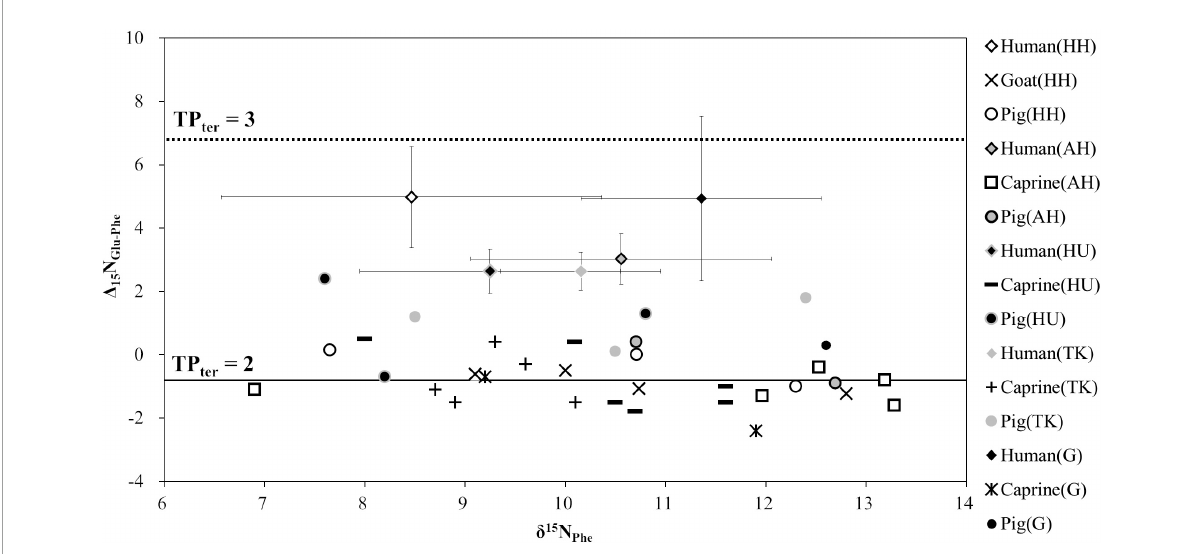
FIGURE4 Comparisons of the δ 15 N Phe and (cid:49) 15 N Glu − Phe of the human, Caprine, and Sus scrofa remains at Hasankeyf Höyük (HK), Asıklı Höyük (AH), Hakemi Use (HU), Tell el-Kerkh (TK), and Gurgy (G). Due to the large number of individuals for humans from each site, the values are summarized by mean and one standard deviation in each site. Solid lines represent expected (cid:49) 15 N Glu − Phe values for either TP ter (trophic positions calculated from δ 15 N Glu and δ 15 N Phe with the equation for terrestrial ecosystem) = 2 (terrestrial herbivore), and the dashed lines represent the expected (cid:49) 15 N Glu − Phe values for either TP ter = 3 (terrestrial